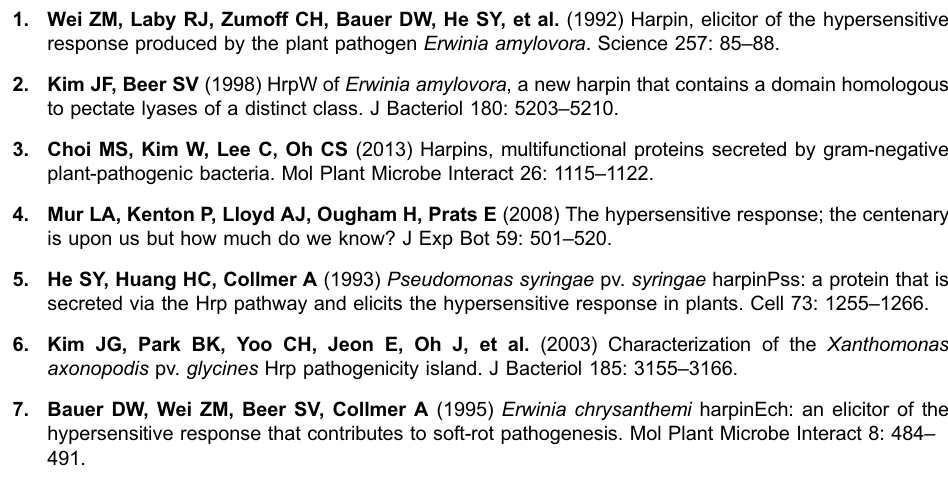
. Lane 2: C-214-HrpZ . Pss Pss fragment corresponding Pss . The Pss